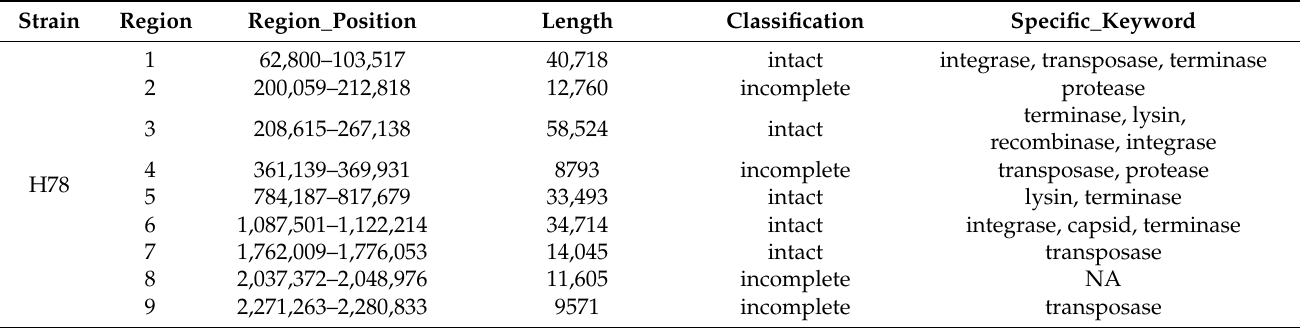
Table 2. Prophage regions identified in G. parasuis